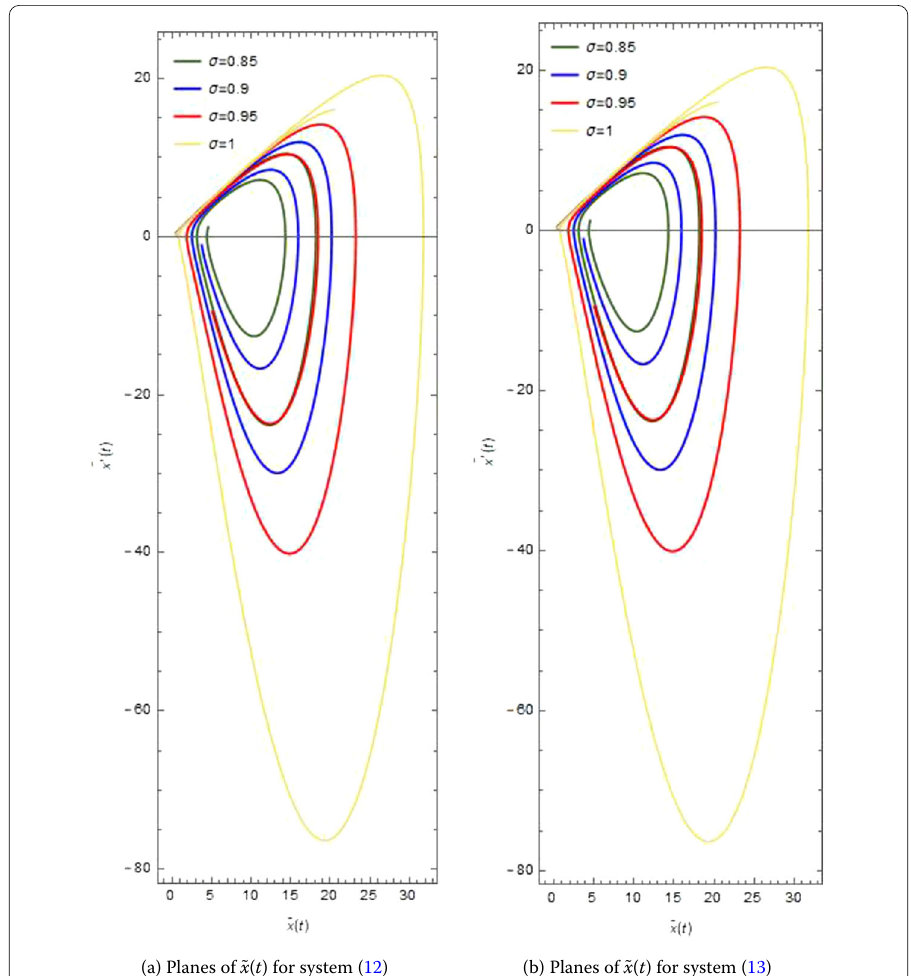
Figure 6 Phase planes for α = 1, q 1 = 0.2, q 2 = 0.7, t ∈ [0,10] and E =